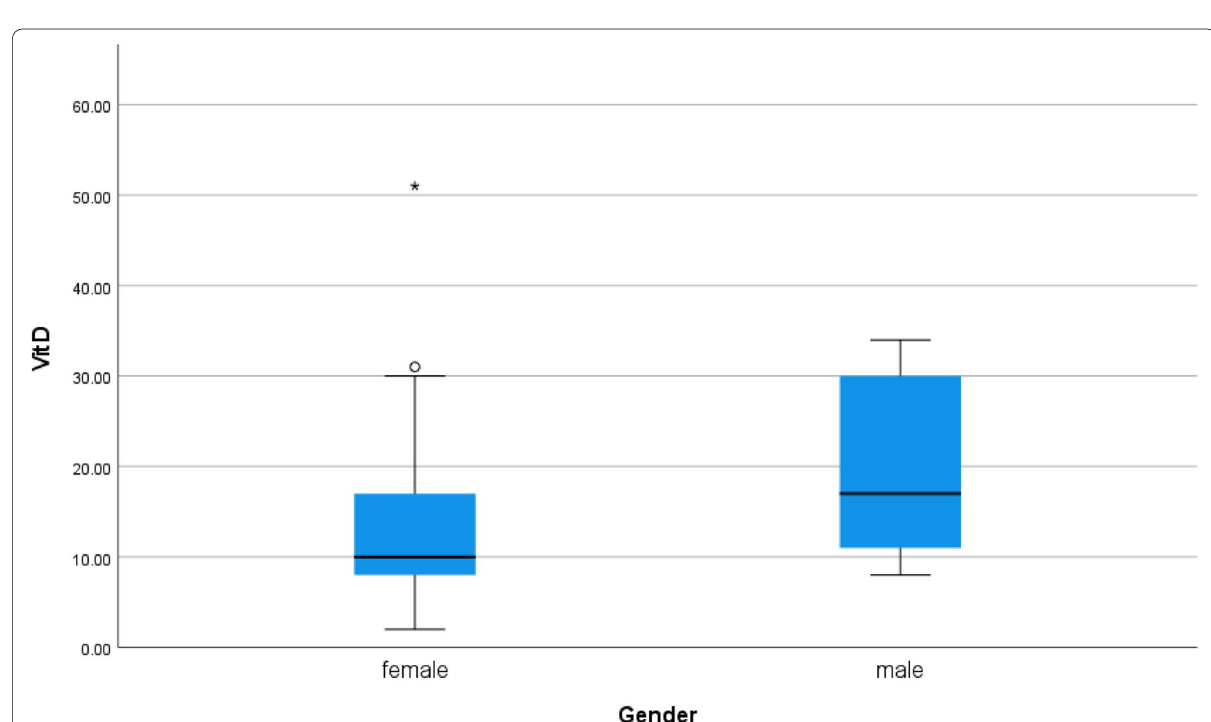
Fig. 18 Correlation between serum vitamin D level and sex of COVID 19 patients (symptomatic and